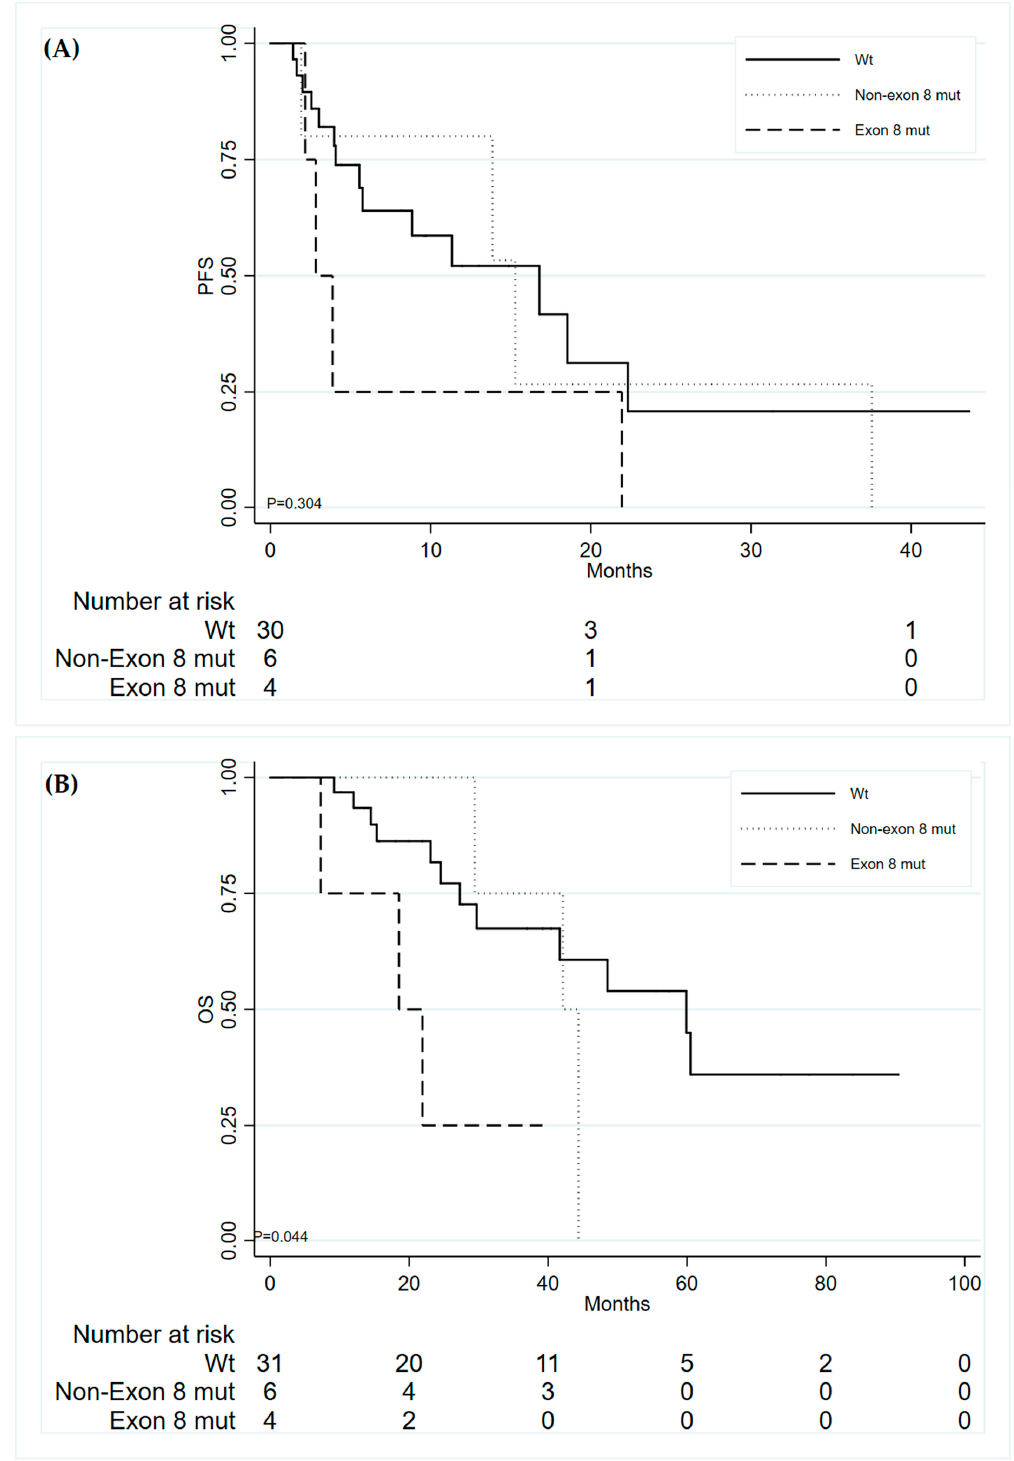
Figure 2. Progression-free survival ( A ) and Overall Survival ( B ) in relation to TP53 mutations of patients with acquired T790M treated with third generation